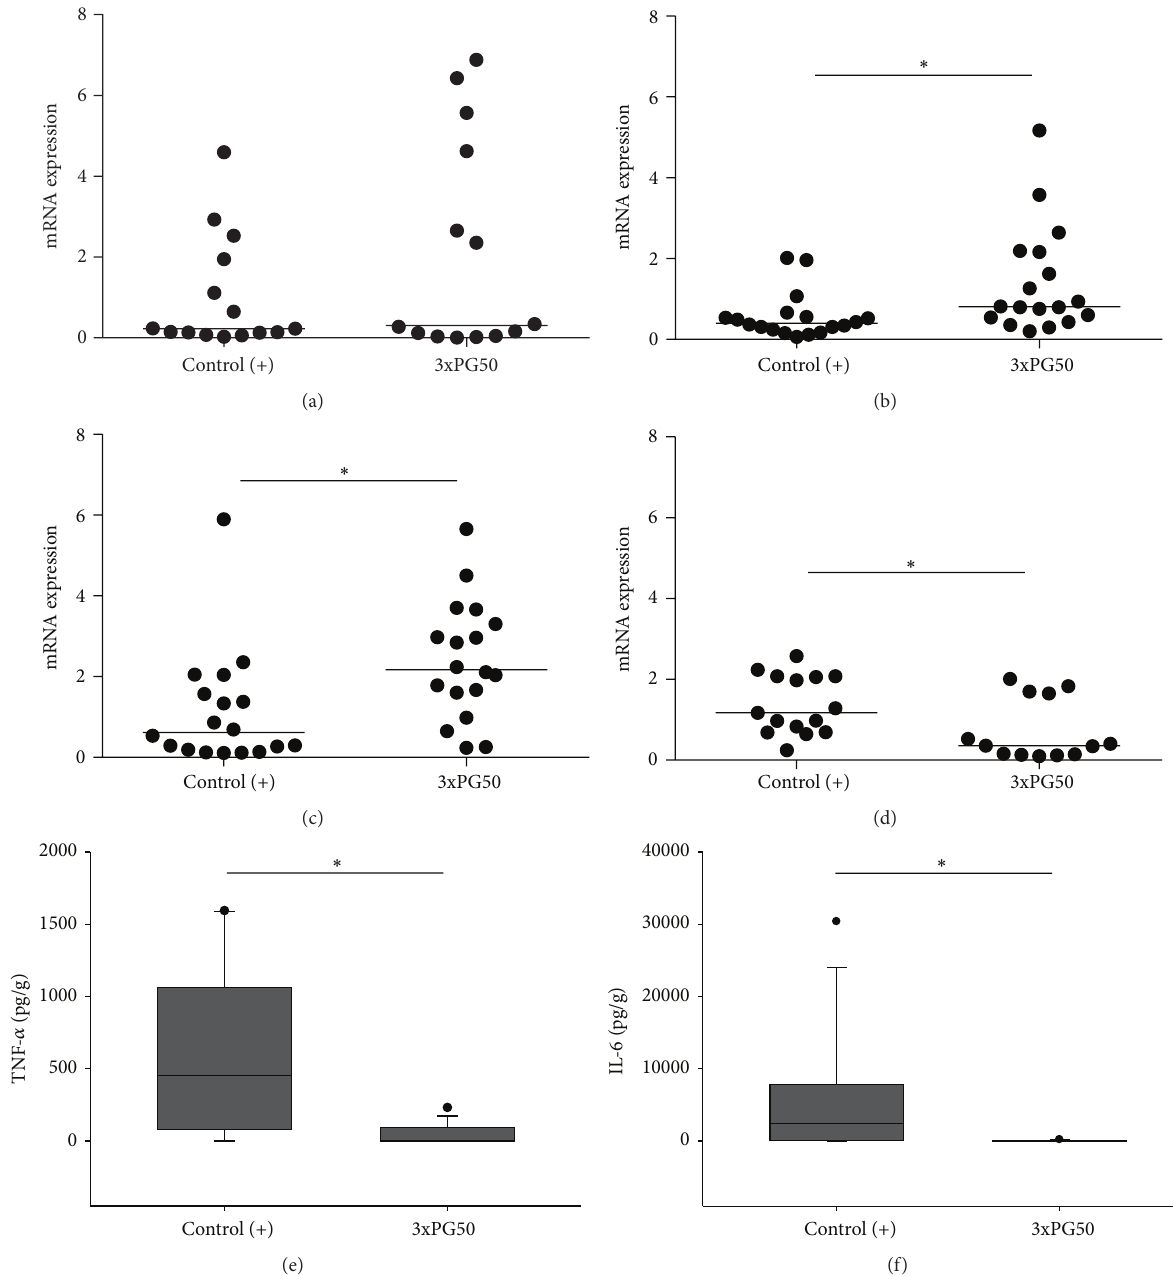
Figure 4: Effect of previous PG inoculation on local T cell transcription factors and cytokine levels. (a) T-bet, (b) ROR- 𝛾 , (c) GATA-3, and (d) Foxp3 mRNA expression in paw homogenates. Quantification was based on fold difference ( 2 −ΔΔ Ct ) between groups, using control ( − ) group as calibrator. (e) TNF- 𝛼 and (f) IL-6 levels in paw homogenates assessed by Cytometric Bead Array. Control (+): arthritic group not previously injected with PG; 3xPG50: arthritic group previously injected with three doses of PG (50 𝜇 g). Hind and forepaws from six to ten animals per group from one representative experiment of two performed. ∗ 𝑝 < 0.05